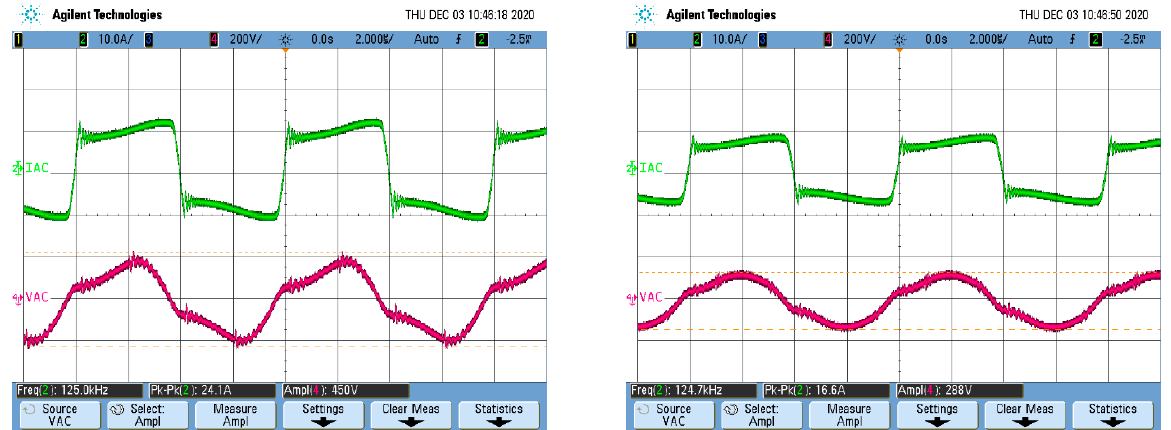
Figure 16. From top to bottom: Output current through the primary side of the transformer, i ac . Output voltage applied to the primary side of the transformer, v ac . Left: Full load condition ( Ψ 0 = Ψ 1 = Ψ 2 = Ψ 3 = 0°). Right: 70% of full load condition ( Ψ 0 = Ψ 1 = 0°, Ψ 2 = Ψ 3 = 90°).